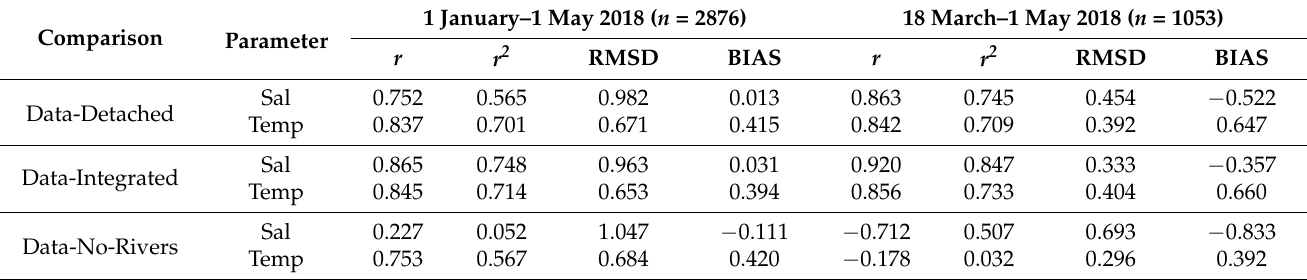
Table 4. Statistical parameters obtained for the validation of the three methodologies against field data (Silleiro moored buoy).